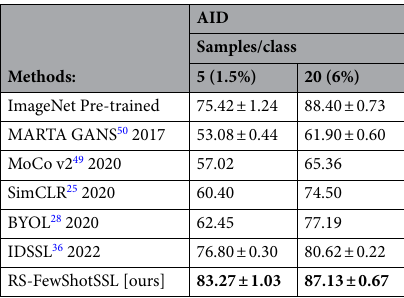
Table 4. RS-FewShotSSL results for the AID dataset and comparison to state-of-the-art methods. Significant values are in bold.